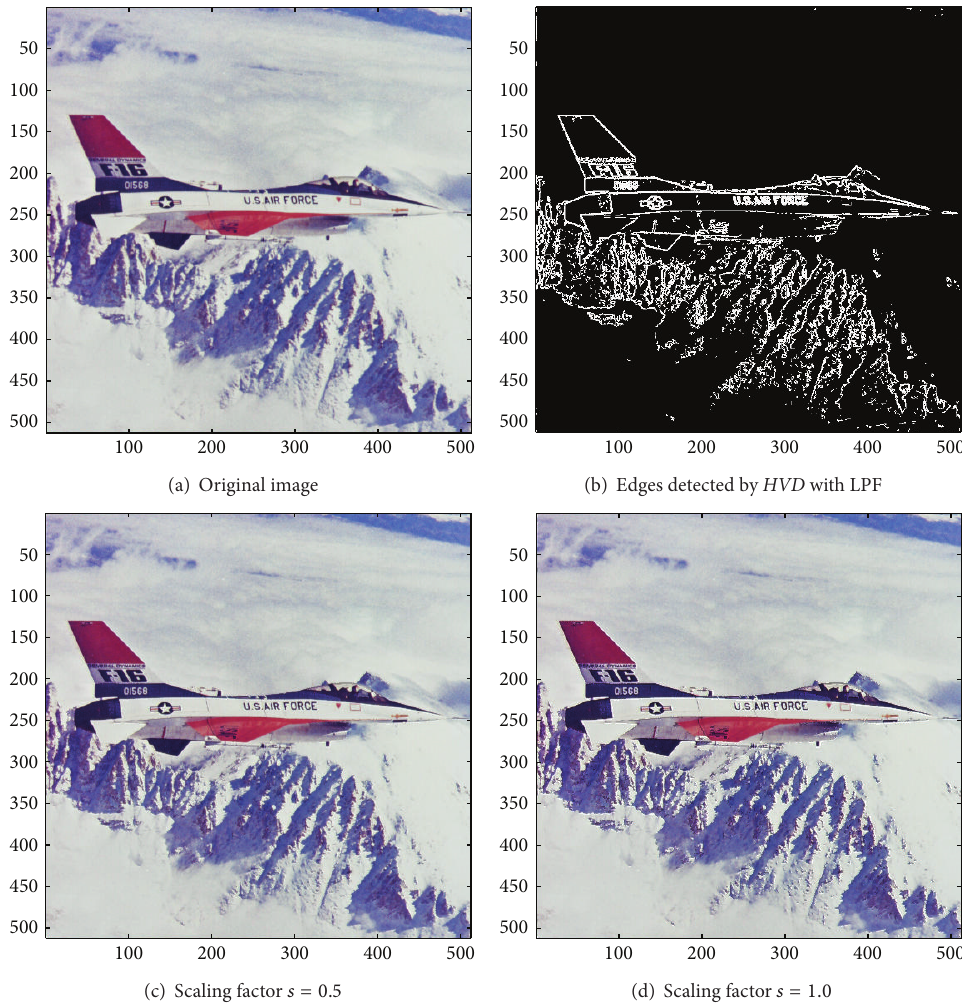
= 15 for HVD . (a) The image “F-16” (512 × 512 color image). (b) Edges detected by HVD with LPF. (c and d) Sharpened results Figure 6: 𝜃 eth by HVD with scaling factors 0.5 and 1.0 ,